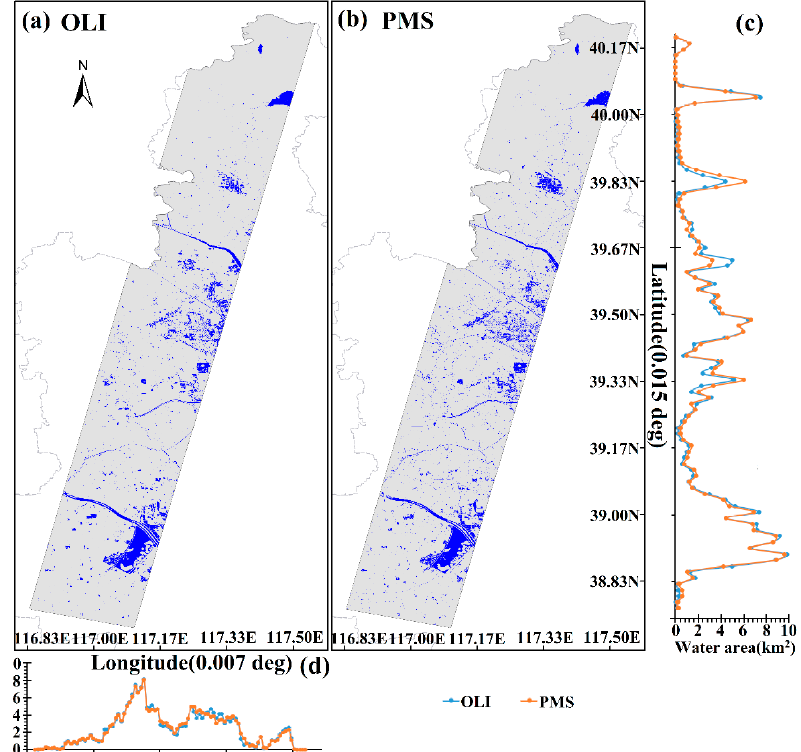
Figure 12. Comparison of water classification result and water area for 30-m 29 May 2019 OLI and 3.9-m resolution GF-2 PMS images using IWCT algorithm. IWCT-based water maps for Landsat OLI ( a ), IWCT-based water maps for GF-2 PMS ( b ), water body area for each 0.015° latitude ( c ) and water body area for each 0.007° longitude ( d ).